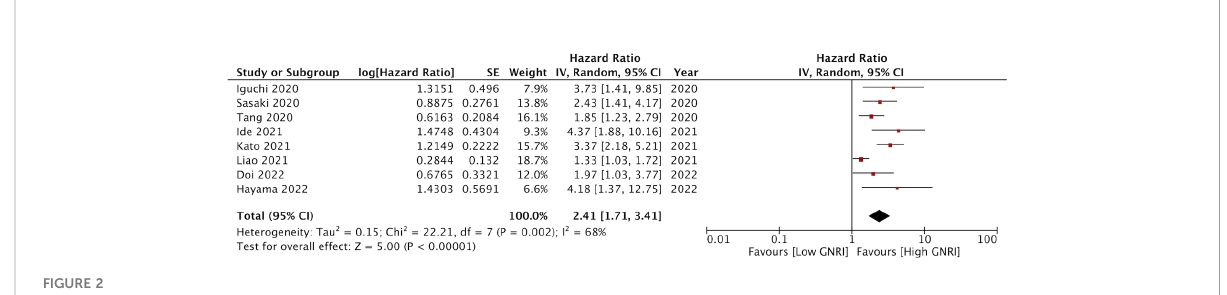
FIGURE 2 Forest plot of the prognostic ability of GNRI for OS in CRC